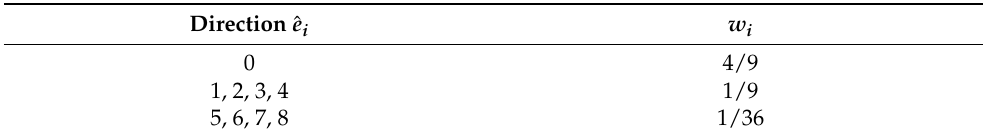
Table 1. Weighting parameter w i values for the D2Q9